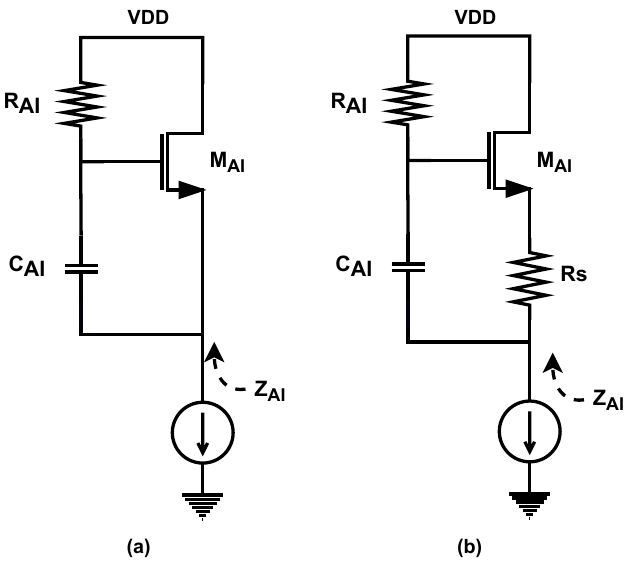
Figure 3. ( a ) Conventional and ( b ) active-inductor with R s